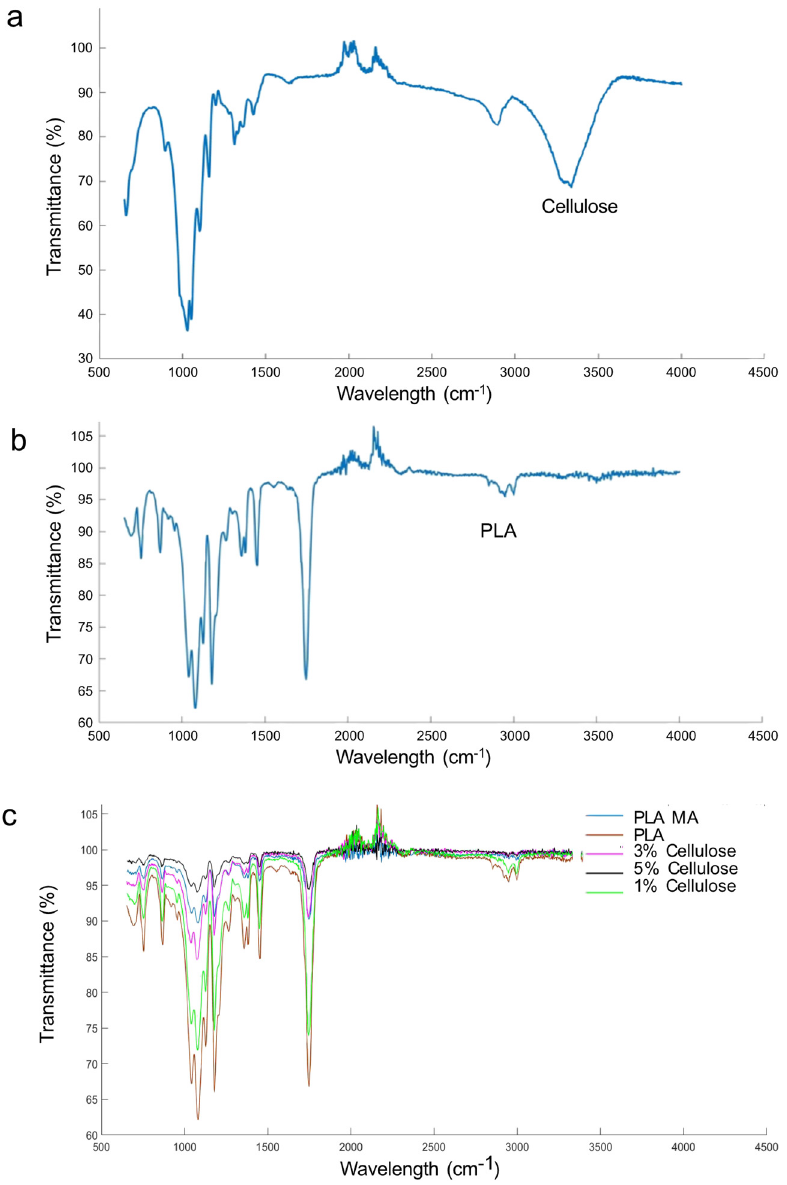
Figure 4: Infrared analysis: ( a ) cellulose, ( b ) neat PLA, and ( c ) composites spectra